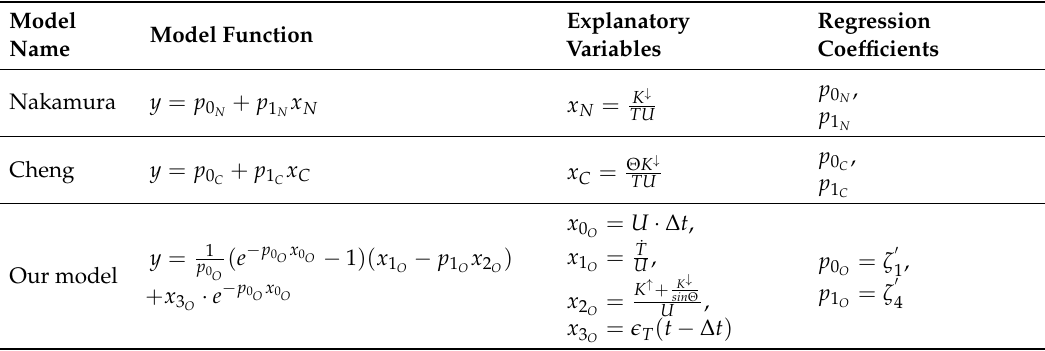
Table 5. Mathematical expression of the regression problems corresponding to each